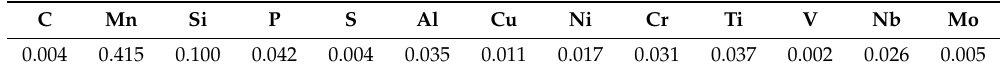
Table 6. OES-chemical element analysis of H220PD + Z100MBO in (wt %).